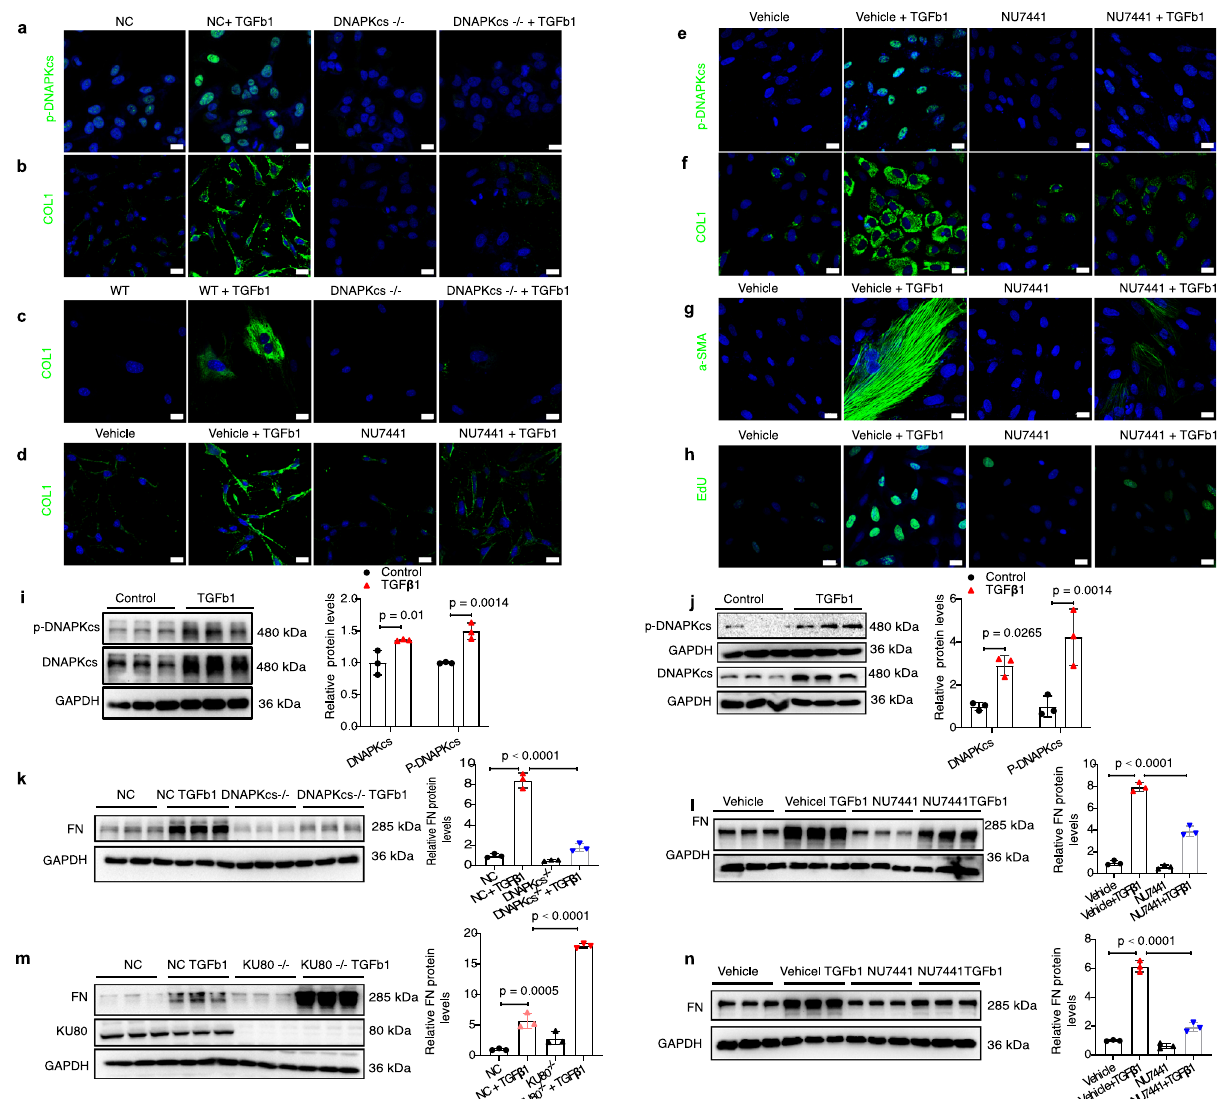
Fig. 4 | Blockade of DNA-PKcs abolishes TGF β 1-induced tubular epithelial cell dedifferentiation and fi broblast activation. a Representative immuno- fl uorescenceimages of p-DNA-PKcs in DNA-PKcs − / − and NC (negative control) HK-2 cells treated with or without TGF β 1 (5ng/ml) for 24h, scale bars: 20 μ m, n =3 biologically independent experiments. b Representative immuno fl uorescence images of COL1A1 in HK-2 cells, primary tubular epithelial cells ( c ) and NU7441 (0.1 μ M) or vehicle-treated HK-2 cells ( d ) treated with or without TGF β 1 (5ng/ml) for 24h, scale bars: 20 μ m. n =3 biologically independent experiments. e Representative immuno fl uorescence images of p-DNA-PKcs, COL1 ( f ), α -SMA ( g ) and EdU ( h ) in NU7441 (0.1 μ M) or vehicle-treated NRK-49F cells treated with or without TGF β 1 (5ng/ml) for 24h, scale bars: 20 μ m, n =3 biologically independent experiments. i Proteinlevelsofp-DNA-PKcsandDNA-PKcsinHK-2cellstreatedwith or without TGF β 1 (5ng/ml) for 24h. Bars represent quanti fi cation results (mean± SD, n =3biologicallyindependentexperiments). j Proteinlevelsofp-DNA-PKcsand